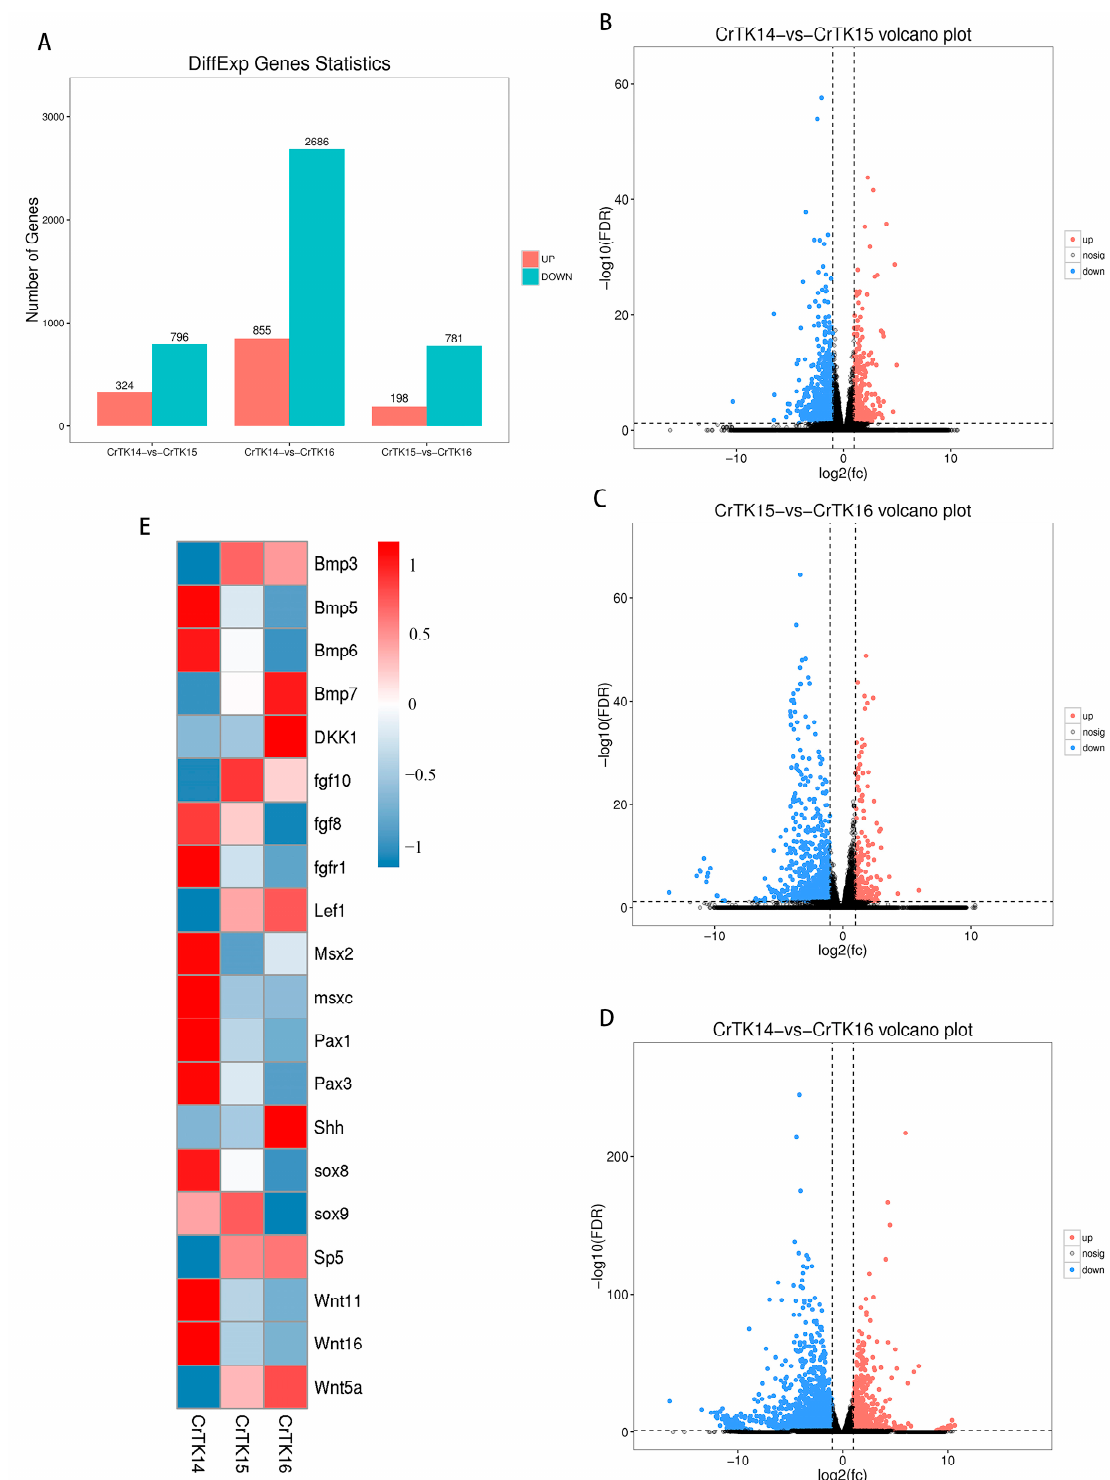
Figure 2. Analysis of differentially express genes (DEGs) during the CR development of M. reevesii . ( A ) Histogram of DEGs. Upregulated genes are shown in red. Downregulated genes are shown in blue. ( B – D ) Volcano plots of three comparison groups. Red dots indicate upregulated DEGs, blue dots indicate downregulated DEGs, and black dots indicate genes that are not differentially expressed. ( E ) Heat map of 20 DEGs. The DEGs have log-transformed expression values. The values in the corresponding spectrum are 1, 0.5, 0, and − 0.5, − 1. Blue represents a lower relative expression and red represents a higher relative